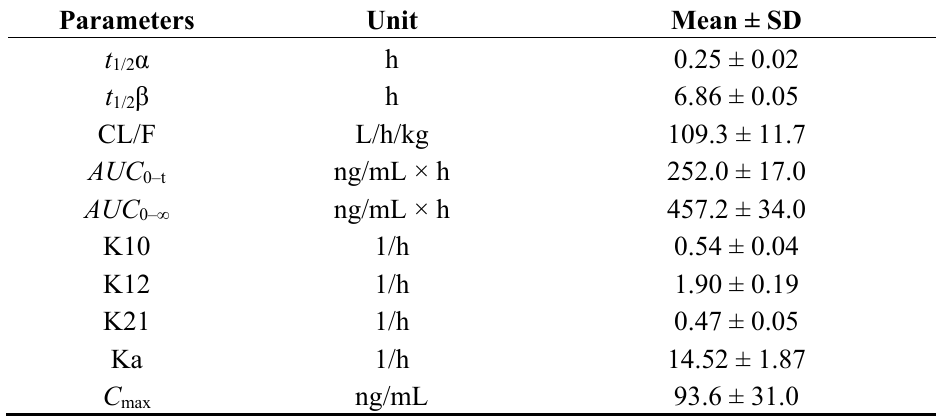
Table 2. The main pharmacokinetic parameters after oral administration of ellagic acid at doses of 50 mg/kg in